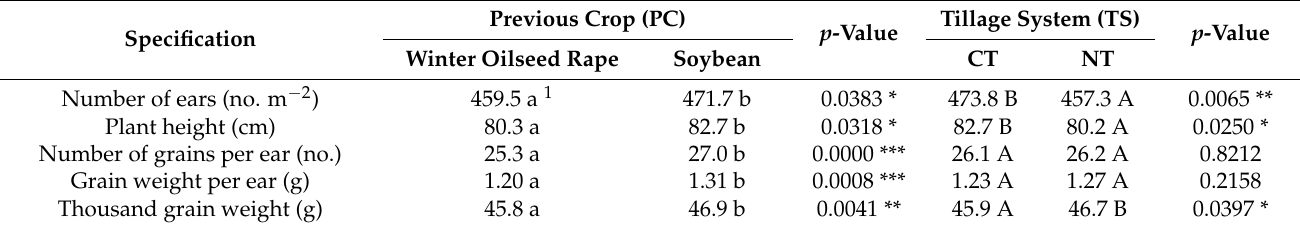
Table 2. Winter wheat yield and crop components depending on previous crop and tillage system (mean for 2014–2017).